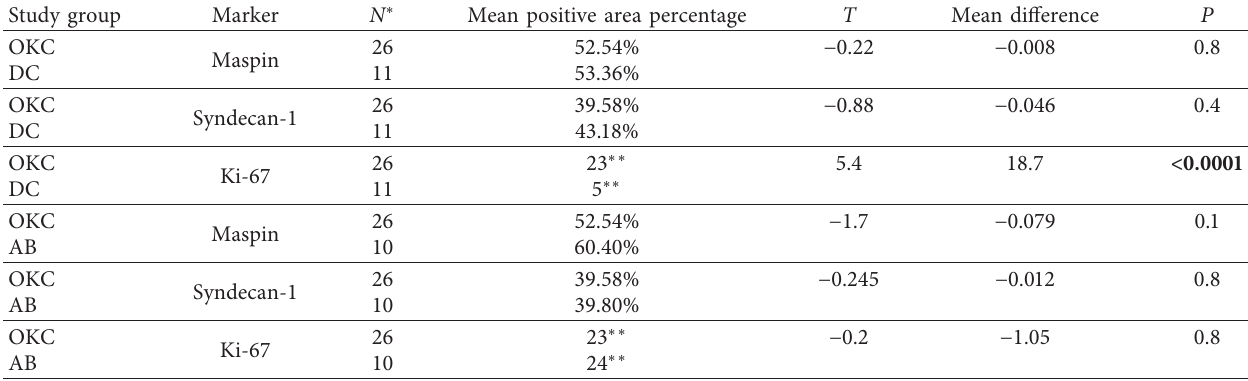
Table 3: Paired comparisons of the mean percentages of maspin and syndecan-1 positive areas, and Ki-67 scores in the OKC with that in the DC and AB, using the independent samples t -test. A significant P -value is shown in bold font. Study